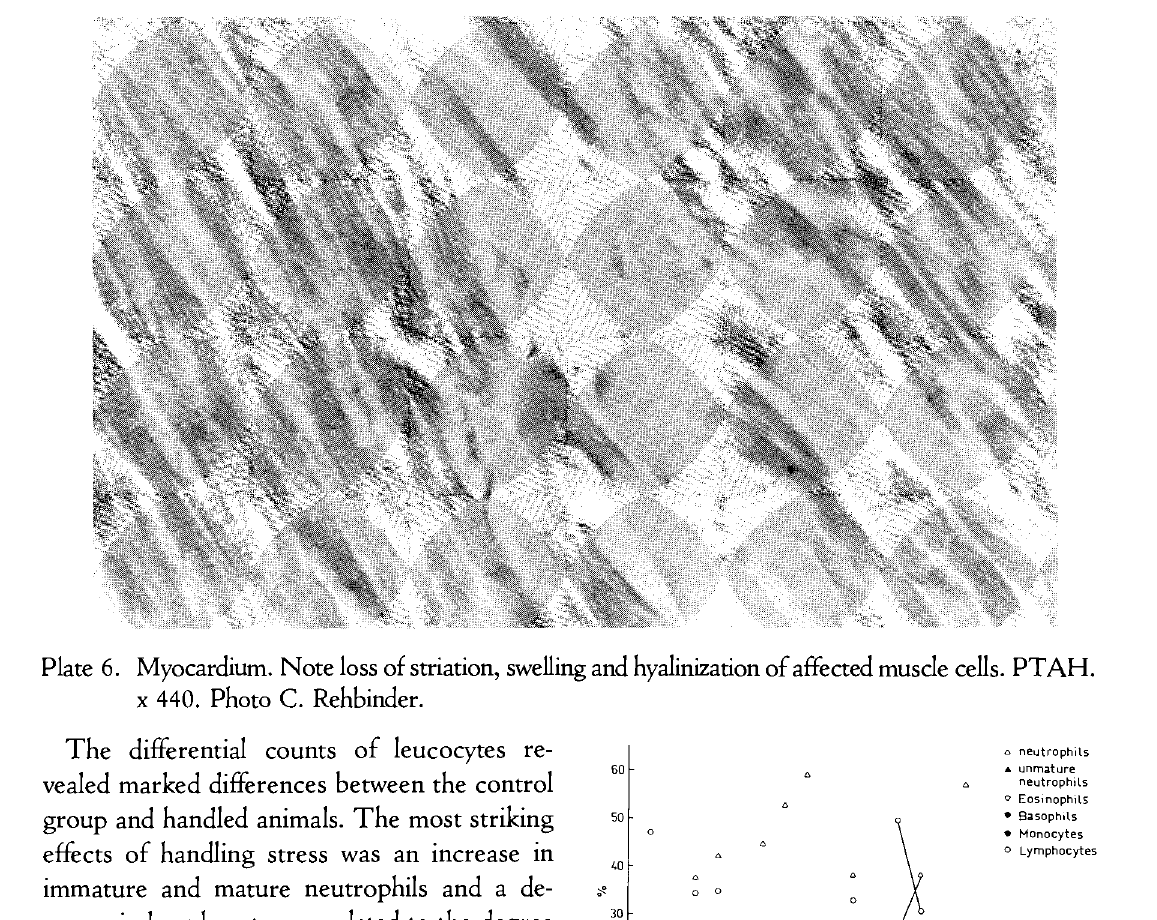
Fig. 9. Differential counts of leucocytes and sampling at slaughter (I ) was remarkable. 2 Urea levels were found to be lower in herds B, D, H, and I than in animals shot in August (herd A), while animals kept overnight in gra zing or resting corrals (herds C, F, and J) revealed significantly higher values than ani mals from all the other herds (Fig. 11). Significantly increased ASAT values were found only in herd F; but individual animals with high levels were found also in herds B,